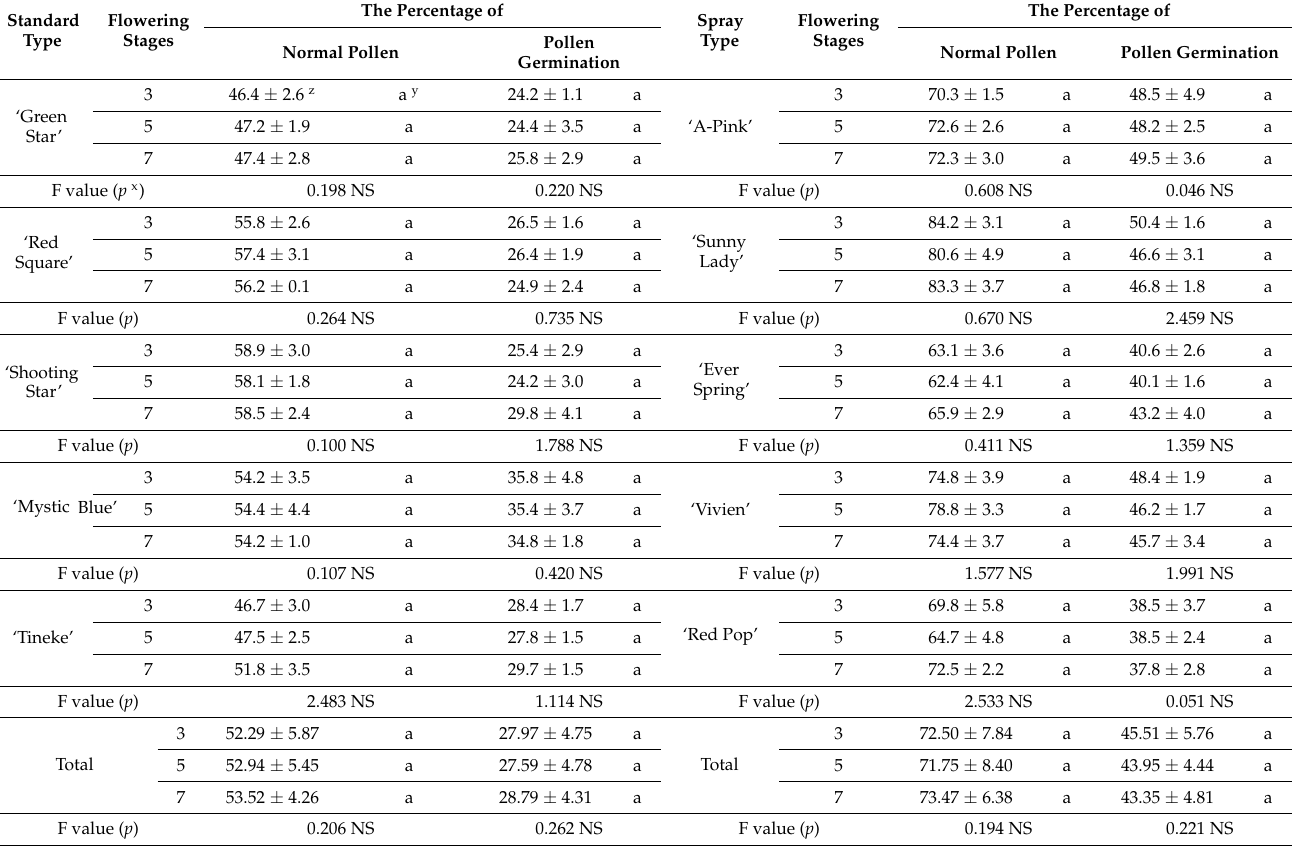
Table 1. Percentages of normal pollen and pollen germination at stages 3, 5, and 7 of